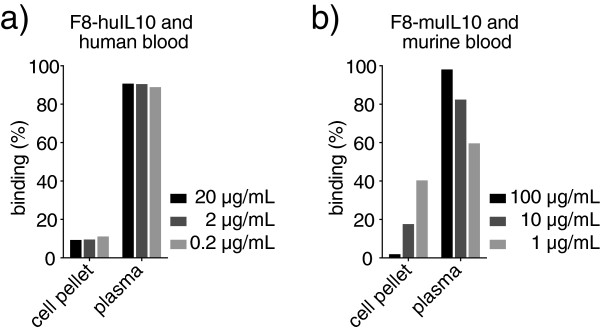
Incubation experiment of radiolabeled immunocytokines with blood, analyzed by a centrifugation-based assay. (a) Different concentrations of F8-huIL10 were incubated with fresh human blood. (b) Different concentrations of F8-muIL10 were incubated with fresh mouse blood. In both cases, inhibitors of coagulation were used. After a centrifugation step and separation of plasma from the cell pellet, radioactivity was counted and expressed as percent of binding.